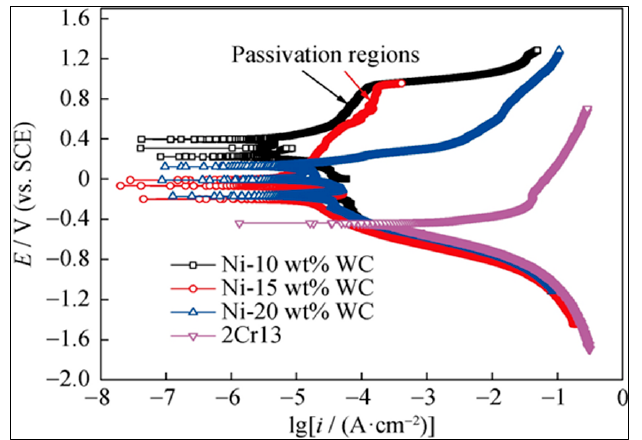
Figure 25. Dynamic potential polarization curves of composite coatings and 2Cr13 steel in a 0.5 mol·L − 1 HCl solution (adapted with permission from Ref. [72] 2021, Springer).